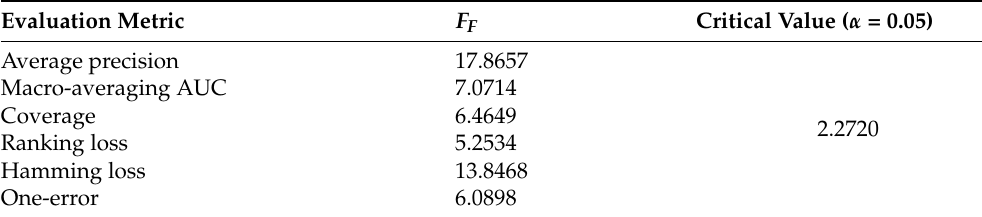
Table 5. Summary of the Friedman statistics F F ( k = 7, N = 10) and the critical value in terms of each evaluation metric ( k : number of comparison algorithms; N : number of data